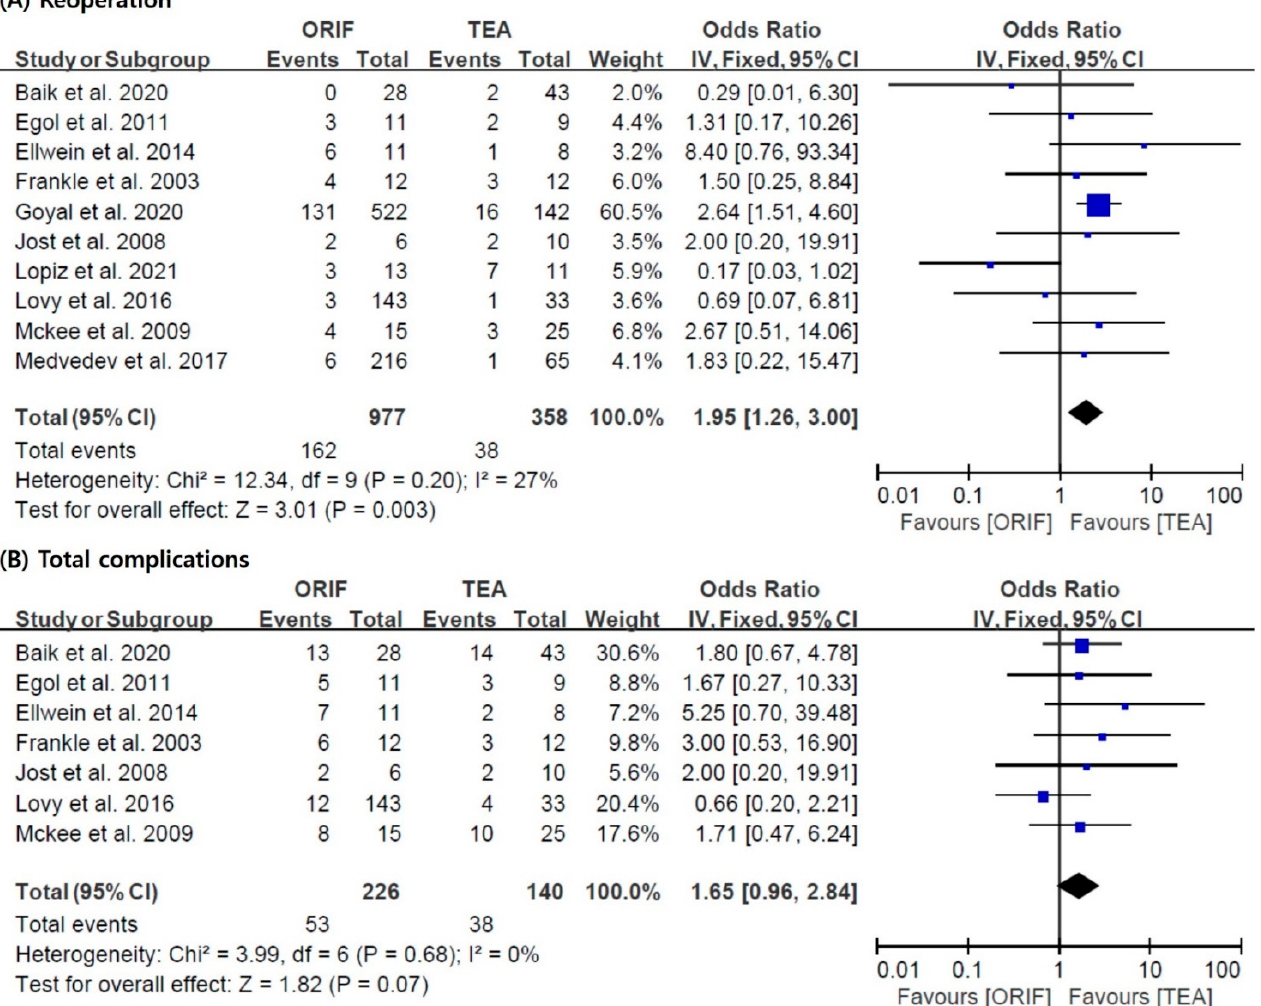
Figure 4. Results of the meta-analysis with respect to reoperation and total complications: ( A ) reoperation and ( B ) total complications [5,10,20,21,24–29]. ORIF: open reduction and internal fixation; TEA: total elbow arthroplasty.